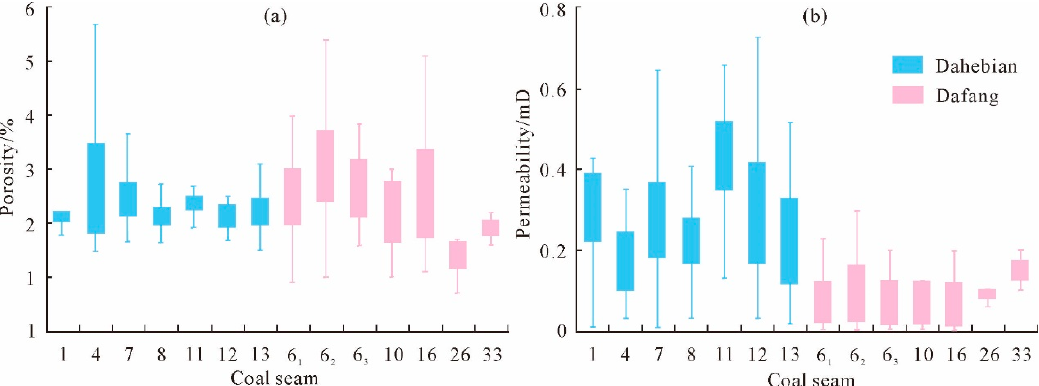
Figure 2. Distribution of porosity ( a ) and permeability ( b ) in various coal seams obtained from the log interpretation.